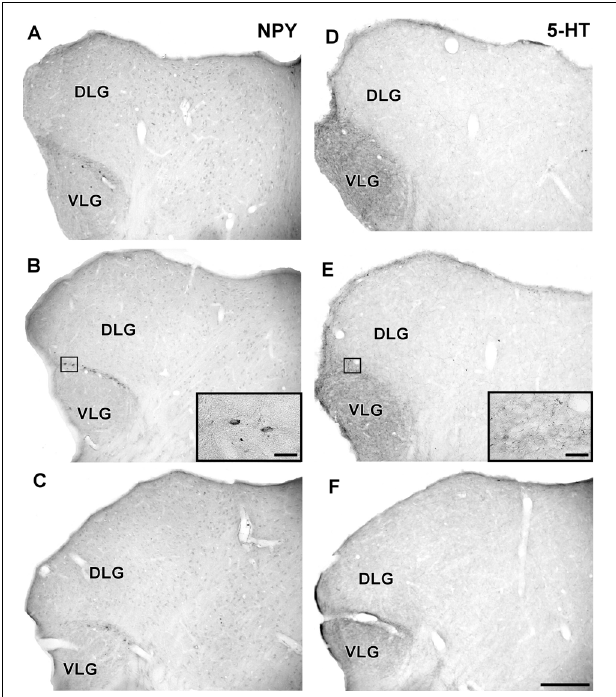
FIGURE 9 | Photomicrographs of the brain sections of flat-faced fruit-eating bat showing the IGL in bright field. (A–C) Immunoreactivity against GAD in the IGL at rostral, middle, and caudal levels, respectively. (D–F) Immunoreactivity against GFAP in the IGL at rostral, middle, and caudal levels, respectively. The magnification of the boxed delimited area is shown in detail in the upper-right corner of each respective picture. DLG, dorsal lateral geniculate nucleus; VLG, ventral lateral geniculate nucleus. Scale bar 500 µ